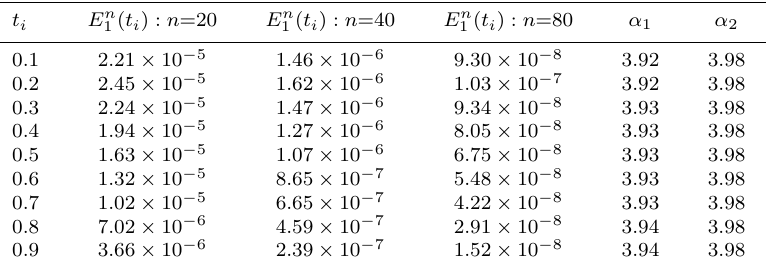
Table 3. Errors and convergence orders for the composite modified Simpson Rule